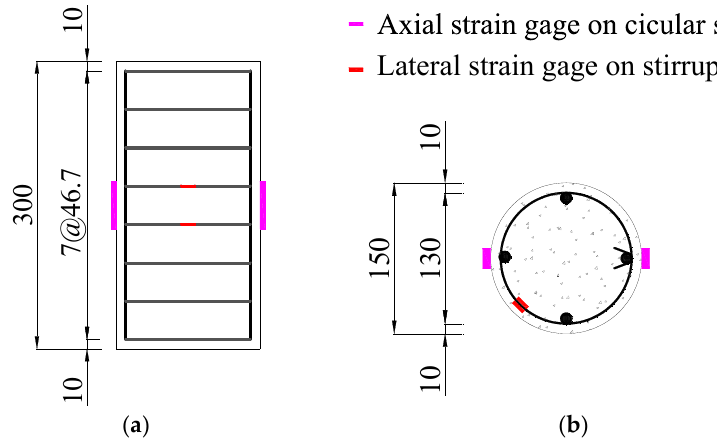
Figure 1. Construction drawing of specimen C2S3Y1 and locations of axial strain gauges and lateral strain gauges: ( a ) horizontal view; and ( b ) top view (unit: mm).